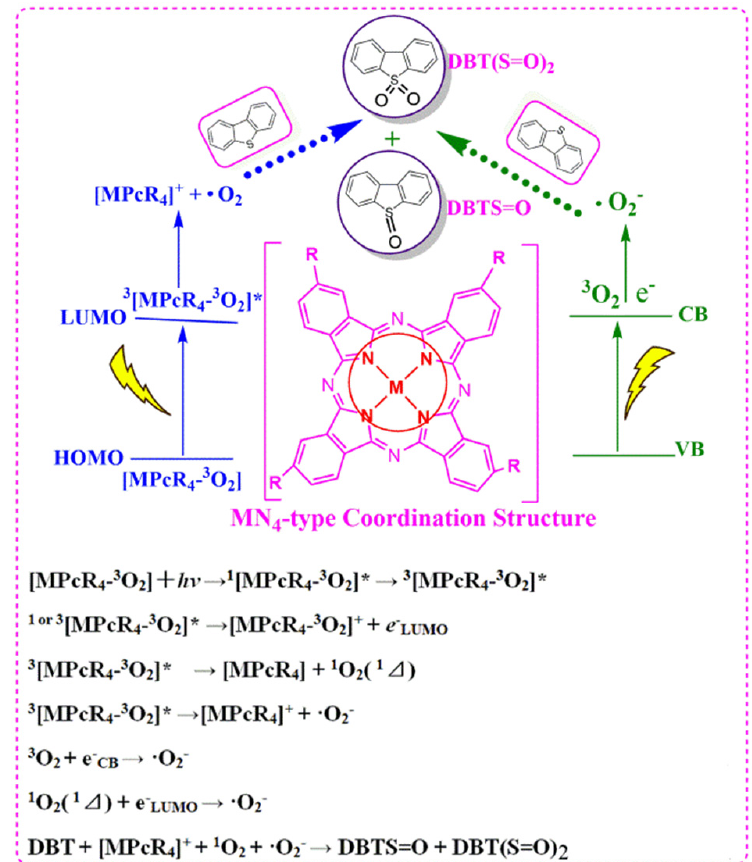
Figure 8. Photocatalytic degradation mechanism of MPcR 4 .